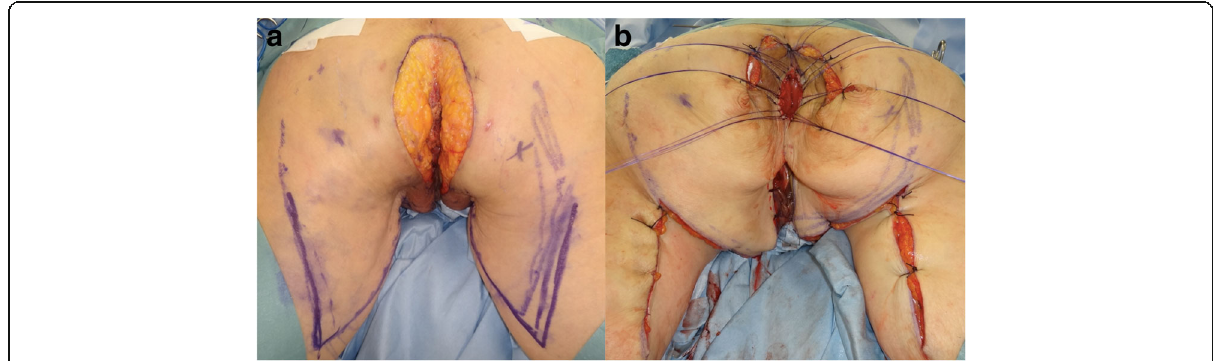
Fig. 3 Surgical findings. a Anal-preserving wide local excision deep to the subcutaneous fat. b Reconstruction using a bilobed gluteal fold flap